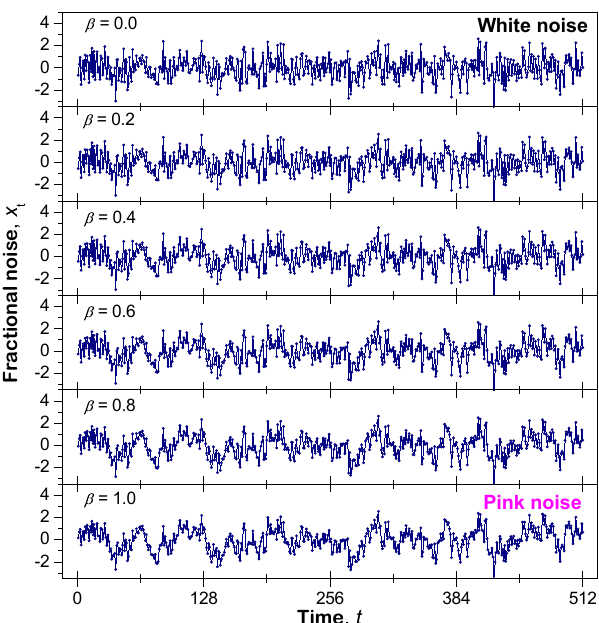
Figure 5. Examples of synthetic fractional Gaussian noises with different modelled strengths of long-range persistence, 0 . 0 ≤ β ≤ 1 . 0. The presented synthetic data series (unitless in magnitude and time), which have 512 elements each, are normalized to have a mean of 0 and a standard deviation of 1, and were created by Fourier filtering (see Appendices 1 and 2 in Witt and Malamud, 2013, for further